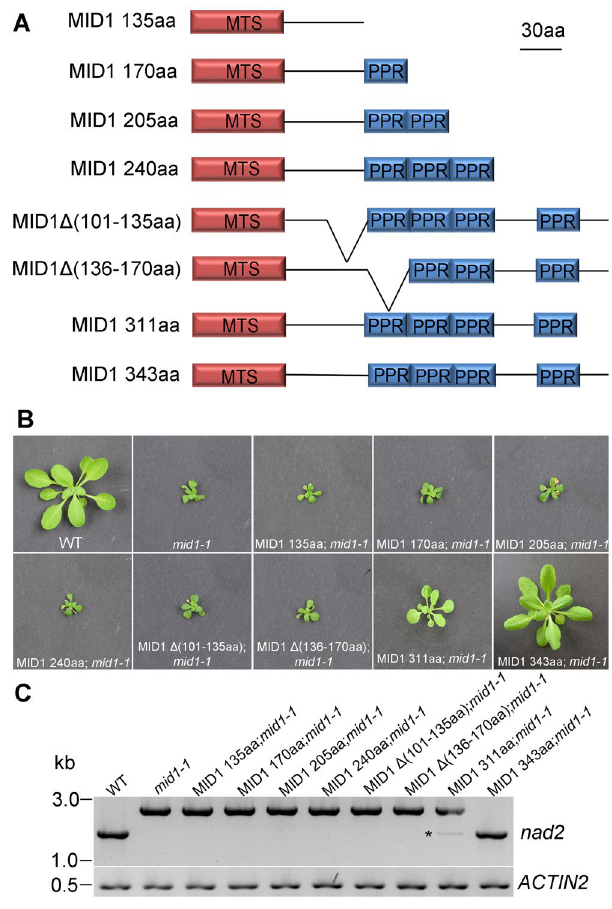
Figure 7. Functional analysis of each domain of MID1 . ( A ) Schematic diagram of MID1 variants. ( B ) The phenotypes of mid1-1 complemented by MID1 variants. Bar = 1 cm. ( C ) RT-PCR analysis of splicing efficiency of nad2 intron 1 in mid1-1 complemented by MID1 variants. ACTIN2 is used as loading